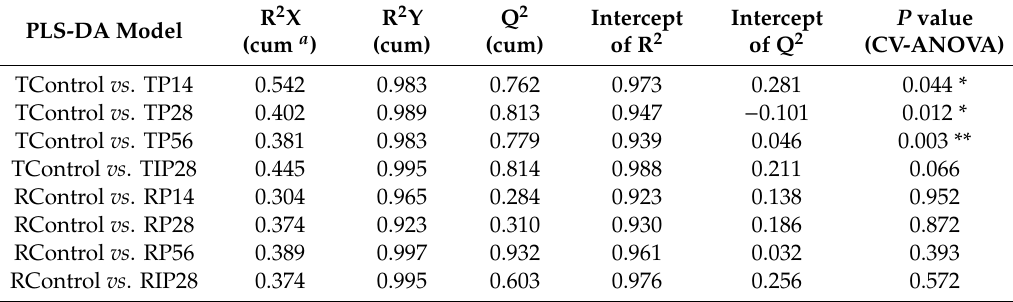
Table 4. Validated parameters of partial least squares discriminate analysis (PLS-DA) models in pairwise